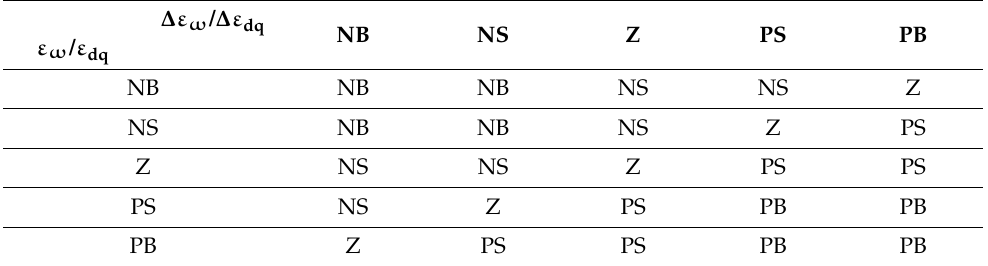
Figure 4. The fuzzy controller configuration: ( a ) inputs ε m function and ( b ) outputs ε m function. Table 1. Fuzzy logic